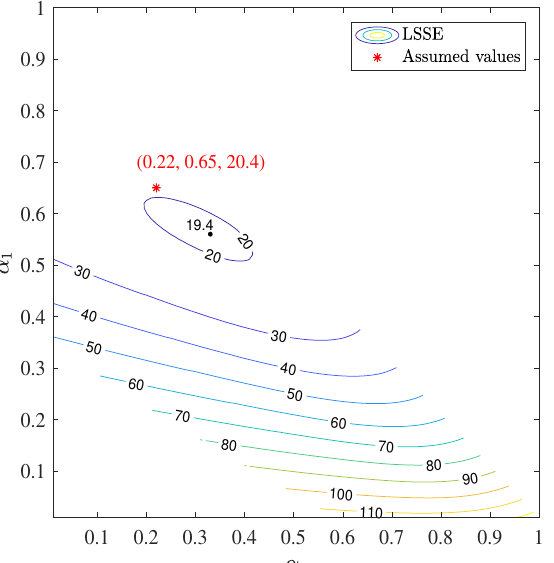
Figure 14. Effect of variations of location weighting factors with b 0 < 0.21 and c 0 > 0.36 on LSSE of overtopping data from all data sets R1, R2, R3, RB, R1N and